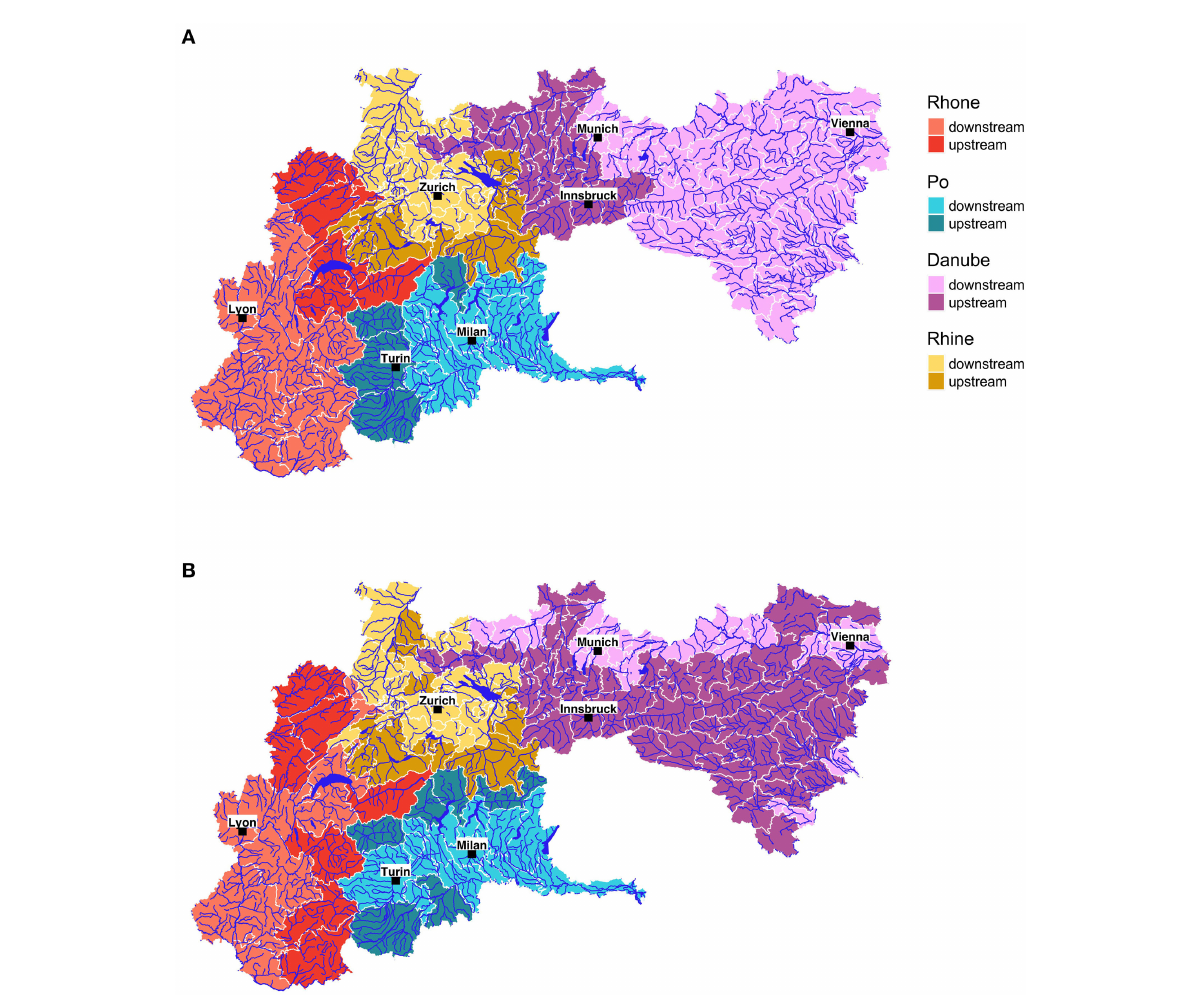
FIGURE3 NUTS 3 regions within the four basins classified into up- and downstream parts applying (A) the distance approach and (B) the human footprint